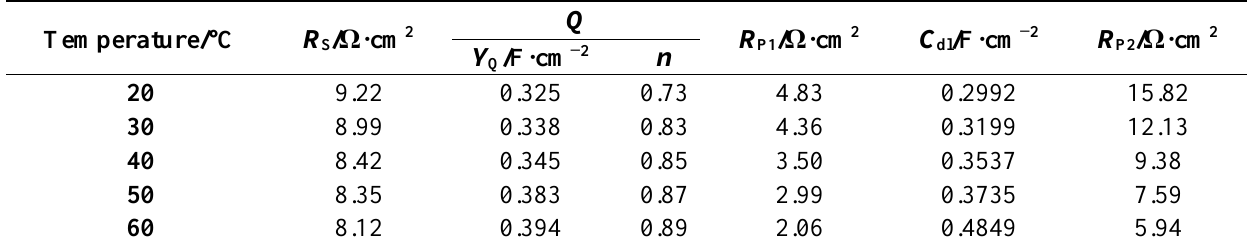
Table 4. EIS parameters obtained for γ-TiAl alloy in 3.5% NaCl solutions after different temperatures.